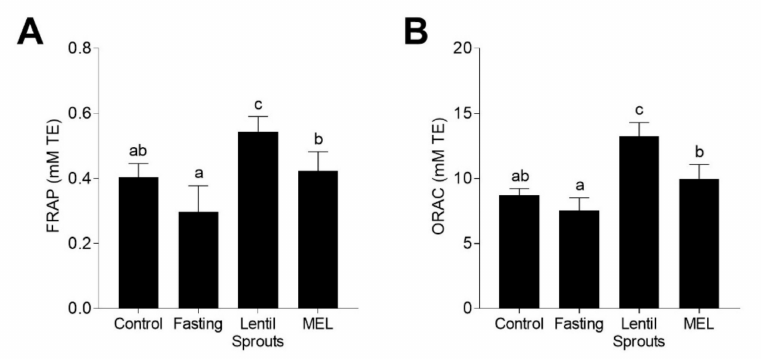
Figure 5. Plasmatic antioxidant capacity measured by FRAP ( A ) and ORAC ( B ) methods followed the four experimental conditions (Control, Fasting, Lentil Sprouts, and MEL). The results are expressed as mean ± SD ( n = 10). Bars with di ff erent letters significantly ( p < 0.05) di ff er according to ANOVA and Tukey’s multiple range